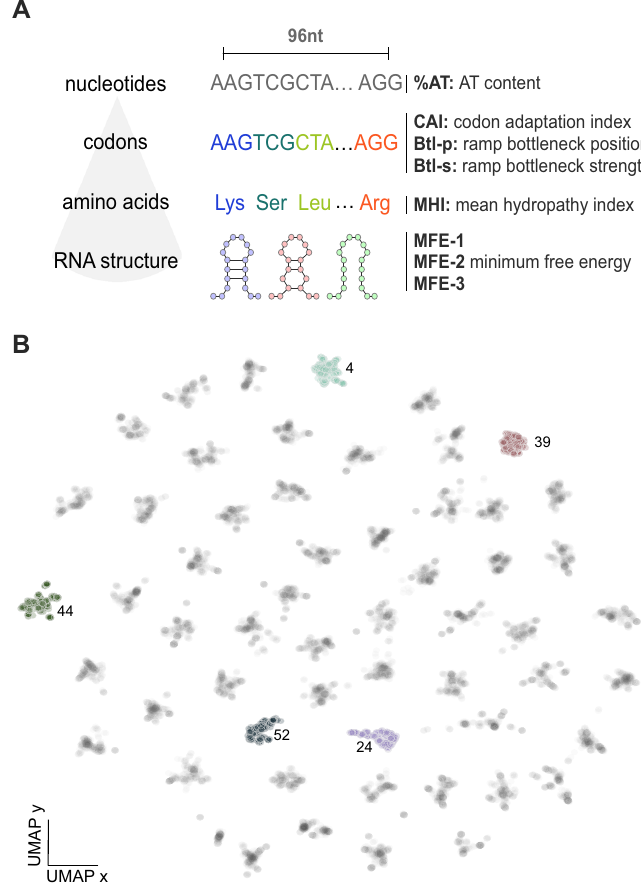
Fig. 1| Characterization ofthetraining data.A Weemployed alargephenotypic screen in Escherichia coli 23 of an sfGFP coding gene preceded by a variable 96nt sequence. The variable region was designed on the basis of eight sequence prop- erties previously described as impacting translational ef fi ciency: nucleotide con- tent (%AT), patterns of codon usage (codon adaptation index, CAI, codon ramp bottleneck position, Btl P , and strength, Btl S ), hydrophobicity of the polypeptide (meanhydrophobicityindex,MHI)andstabilityofthreesecondarystructurestiled along the transcript (MFE-1, MFE-2, and MFE-3). A total of 56 seed sequences were designed to provide a broad coverage of the sequence space, and then subjected to controlled randomization to create 56 mutational series of ~4000 sequences each. After removal of variants with missing measurements, the dataset contains 228,000 sequences. Violin plots show the distribution of the average value of the eight properties across the 56 mutational series; the biophysical properties were normalized to the range [0, 1] and then averaged across series. For all violins, the white circle indicates the median, box edges are at the 25th and 75th percentiles,